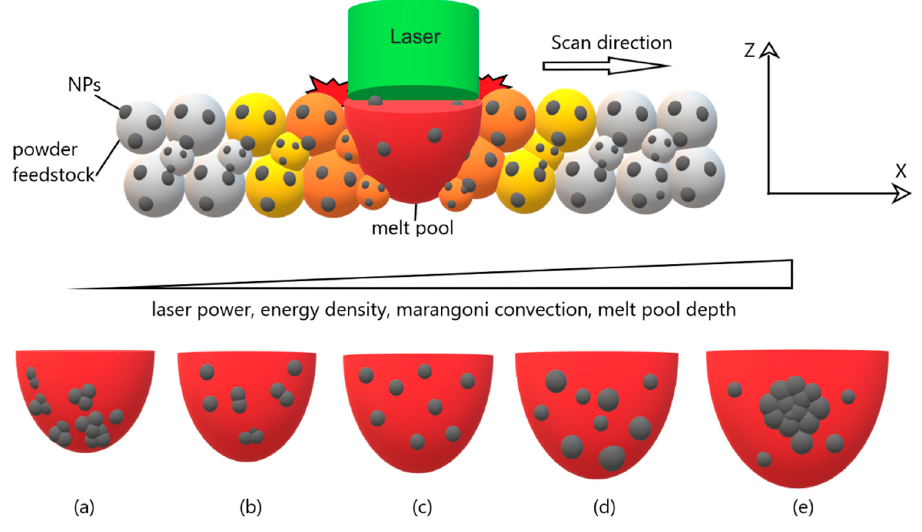
Figure 7. Illustration of nanoparticle distribution in the melt pool during laser powder bed fusion process. Depending on the process conditions, within the melt pool volume, the undissolved nanoparticles can be ( a ) poorly mixed and aggre- gated at the bottom, ( b ) loosely accumulated with improved distribution, ( c ) homogeneously distributed without accu- mulation, ( d ) well distributed but coarsened, and ( e ) highly aggregated to (sub)micrometer